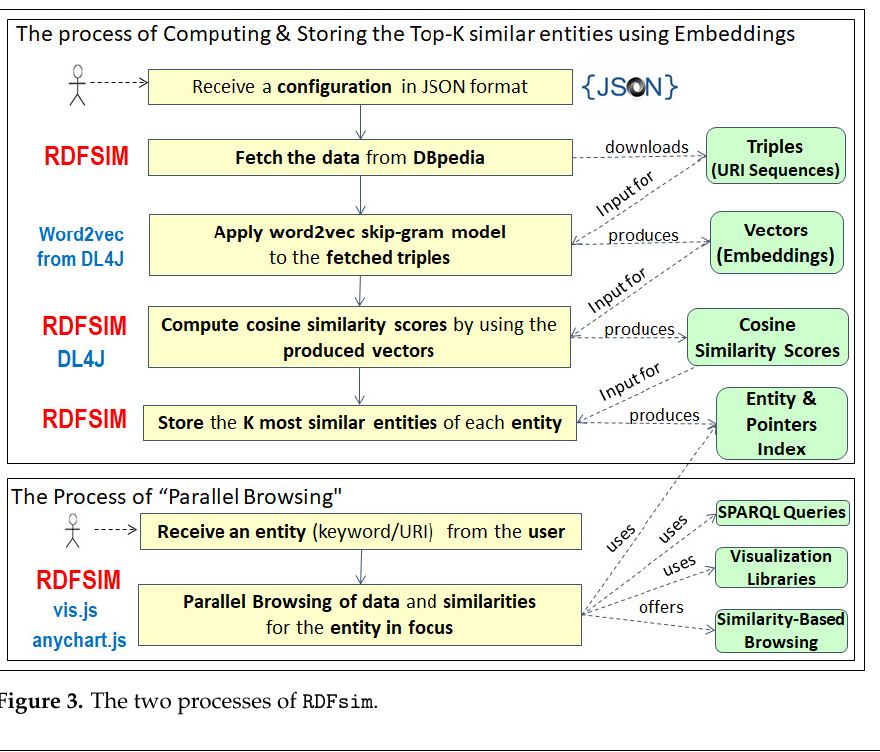
Figure 3. The two processes of RDFsim .